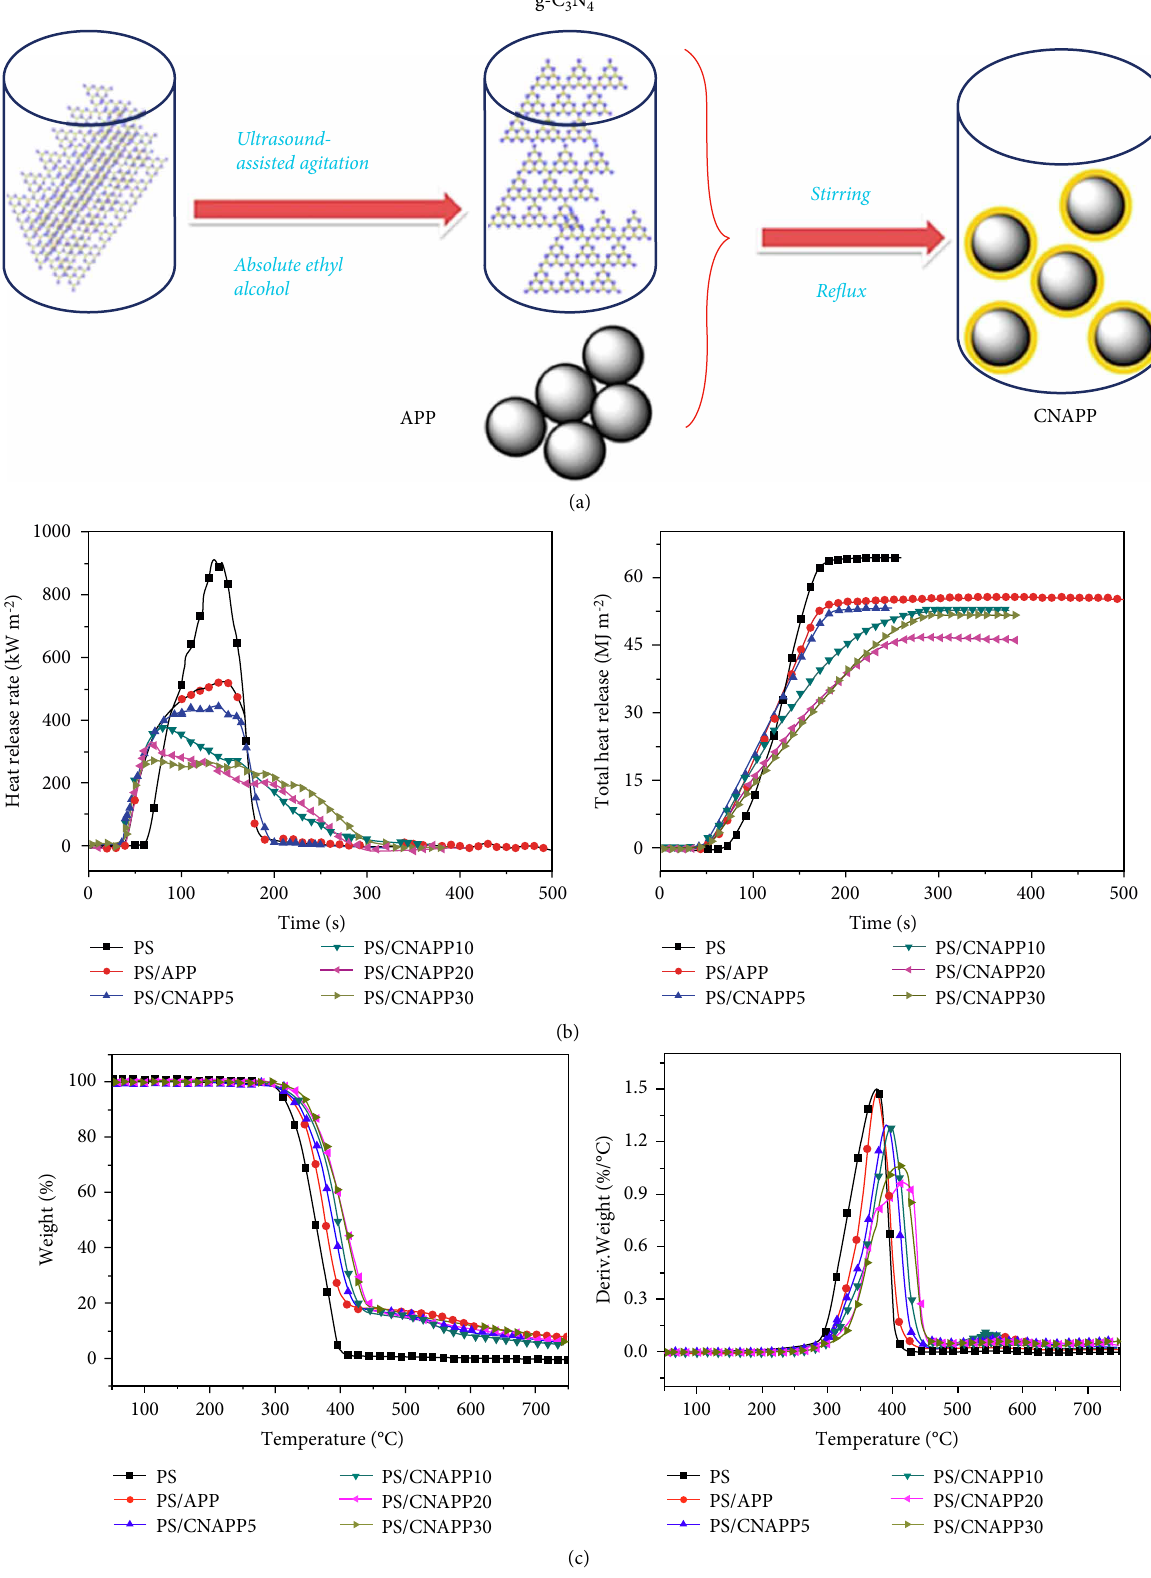
Figure 9: (a) The preparation process of CNAPP. (b) The HRR and THR curves of PS and its composites. (c) TG and DTG curves of PS and its composites. Adapted from